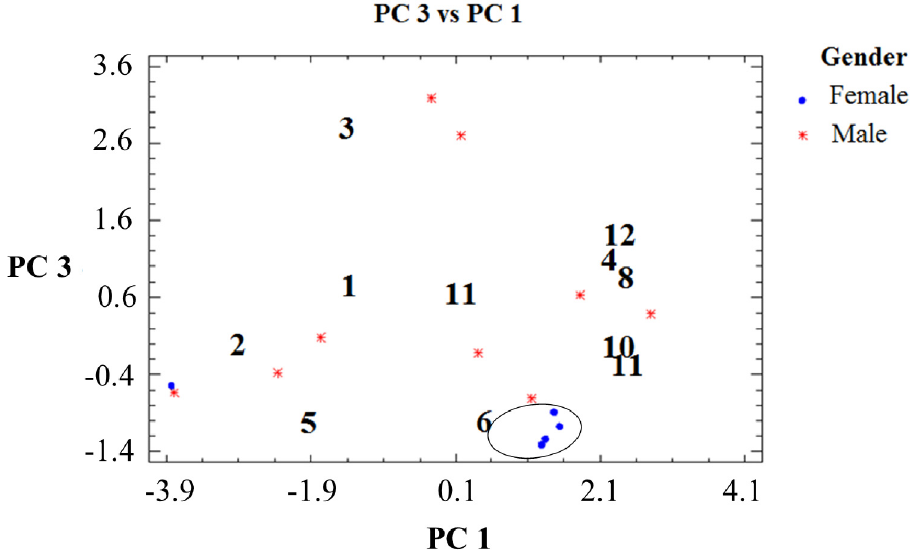
Figure 4. Graphic display of variables for selected components in the June collection.